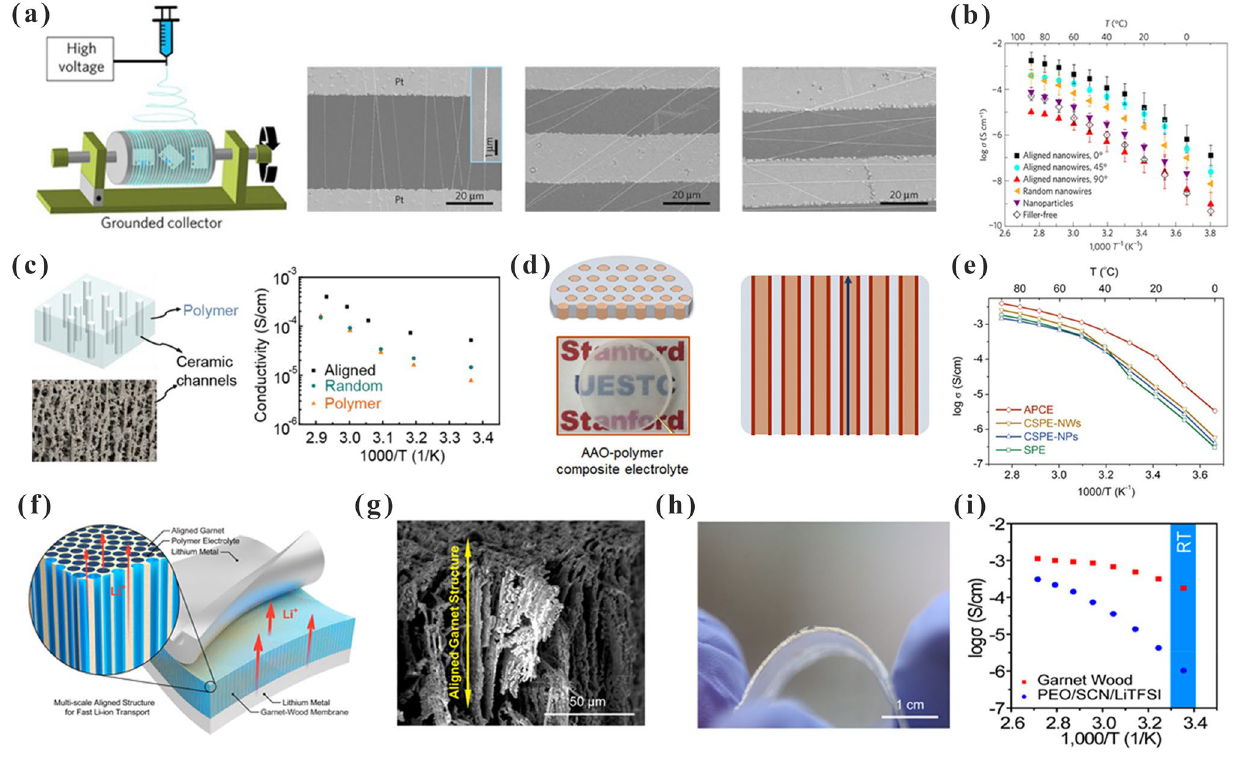
Fig. 5 a CPEs with different aligned LLTO nanowires; b Arrhenius plots of different aligned LLTO-PAN CPEs. Adapted with permission from Ref. [110]. c Schematic diagram of vertically aligned LATP in polymers and the ionic conductivity plots. Adapted with permission from Ref. [111]. d Schematics of AAO-PEO CPEs; e Interfacial ionic conductivities of CPEs based on AAO disks. Adapted with permission from Ref. [112]. f Schematic of multiscale aligned LLZO incorporated with PEO; g SEM images showing the alignment of channels of LLZO-PEO CPEs; h Photograph of the LLZO-PEO CPEs; i Ionic conductivity of LLTO-PEO CPEs and PEO SPEs. Adapted with permission from Ref.